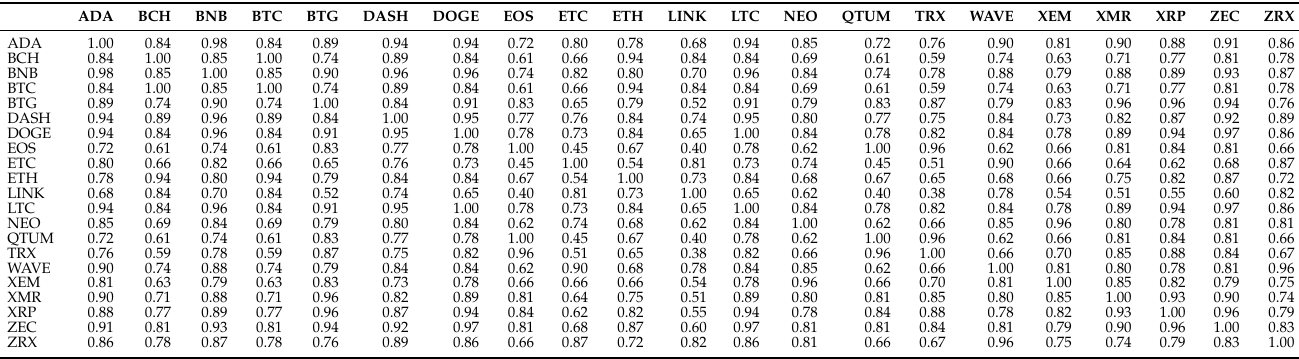
Table 5. Pairwise similarity among cryptocurrencies. Class